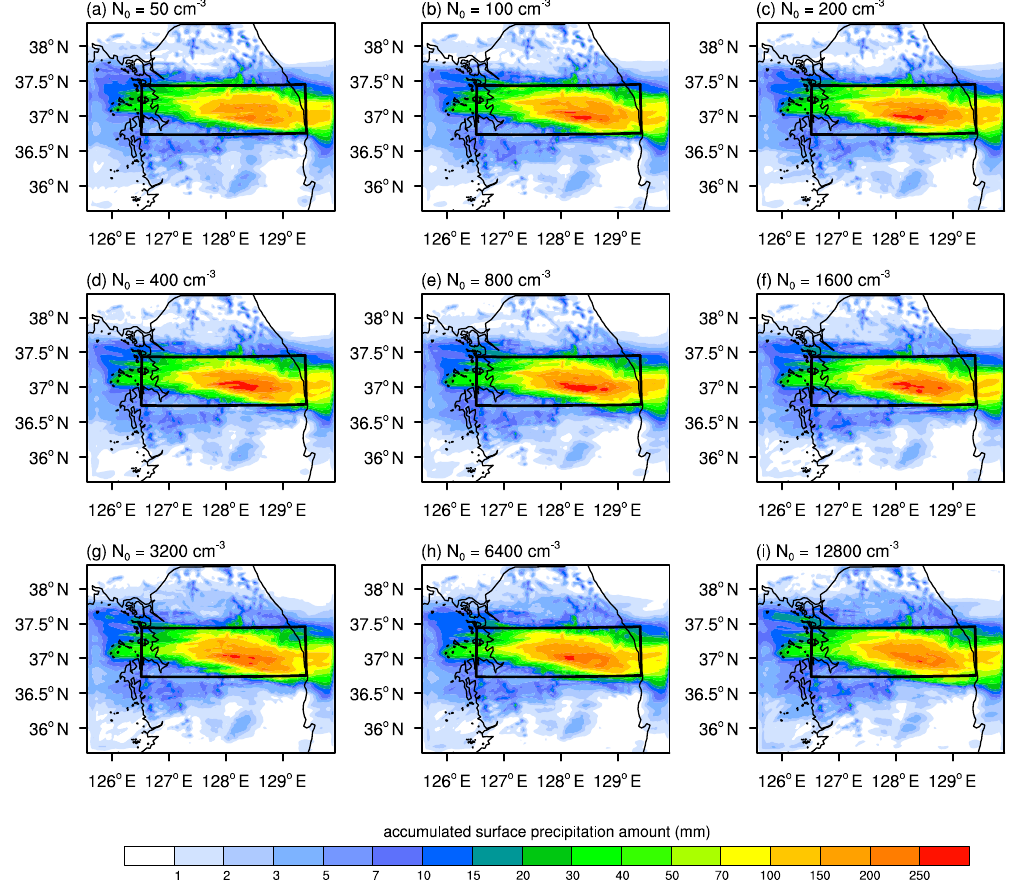
Figure 5. Spatial distributions of the surface precipitation amount accumulated over the 18 h period in the cases of N 0 = ( a ) 50, ( b ) 100, ( c ) 200, ( d ) 400, ( e ) 800, ( f ) 1600, ( g ) 3200, ( h ) 6400, and ( i ) 12,800 cm − 3 . The boxed region in each figure defines the analysis region for this study, corresponding to where the precipitation is concentrated.